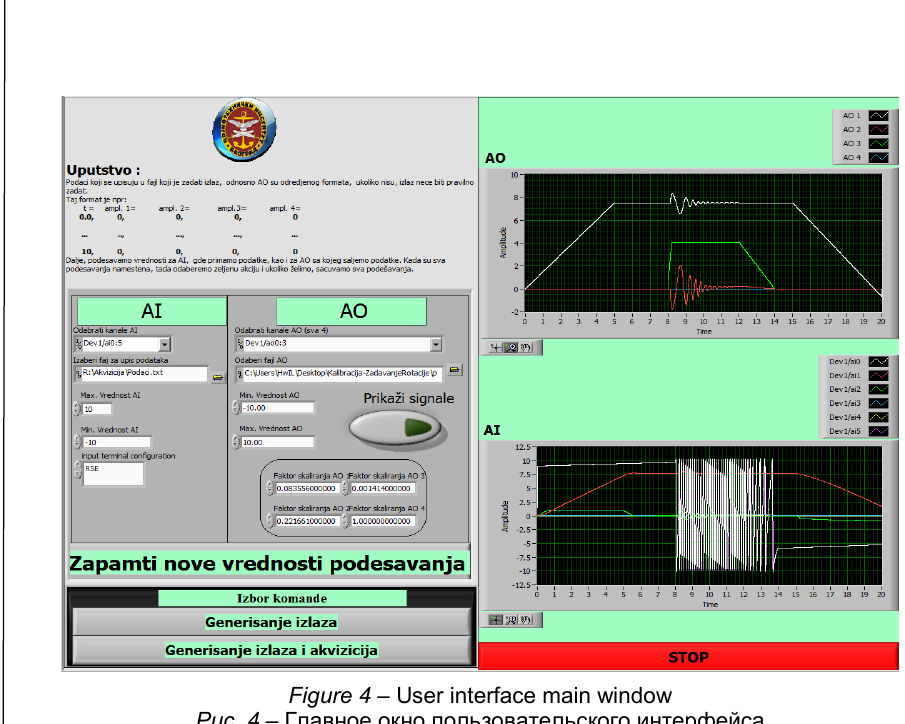
Figure 4 – User interface main window Рис . 4 – Главное окно пользовательского